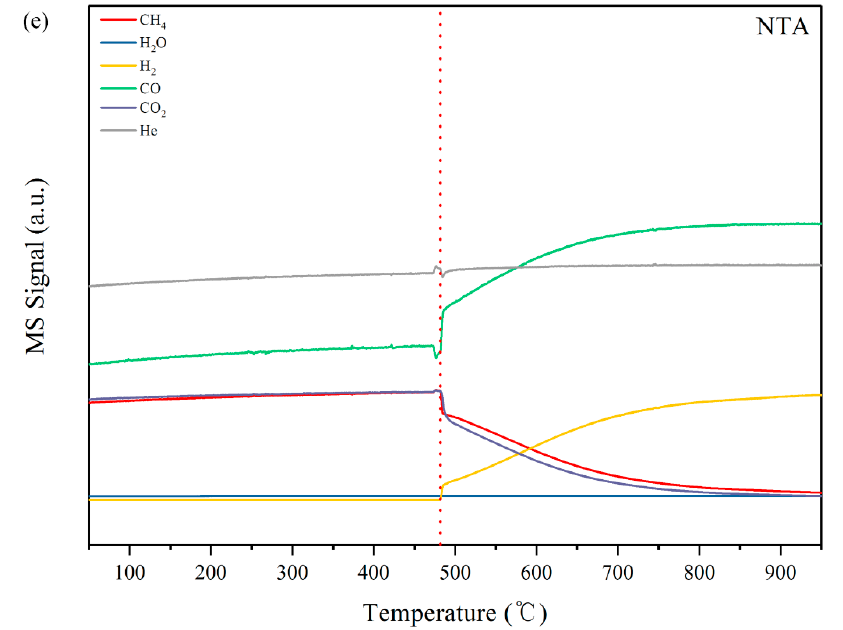
Figure 3. Temperature-programmed surface reaction profiles over the prepared catalysts with different Zr/Ti ratio in the dry reforming of methane ( a ) NZA, ( b ) NZTA (4), ( c ) NZTA (2), ( d ) NZTA (1), ( e ) NTA; Reaction condition: Total flow: 50 cm 3 /min; feed composition: CH 4 :CO 2 :He = 1:1:8. Catalysts 2020 , 10 , x FOR PEER REVIEW